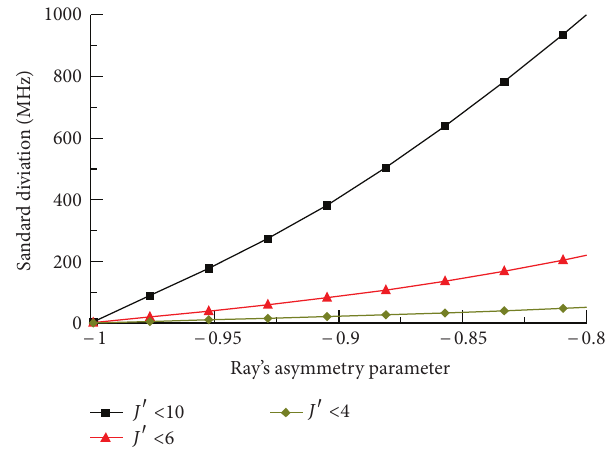
F 9: A plot of the root-mean-standard deviation in MHz pertaining to the comparison of actual rigid rotor frequencies compared to those generated using the simple formulae given in Table 1 for several different molecular asymmetries.